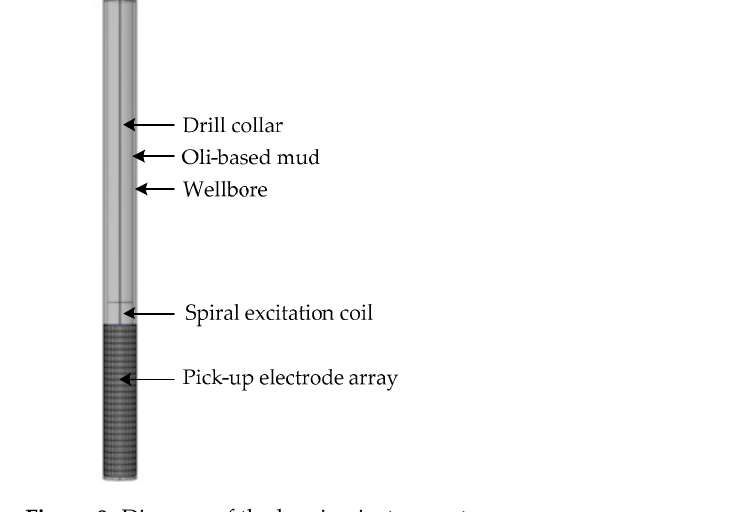
Figure 9. Diagram of the logging instrument.